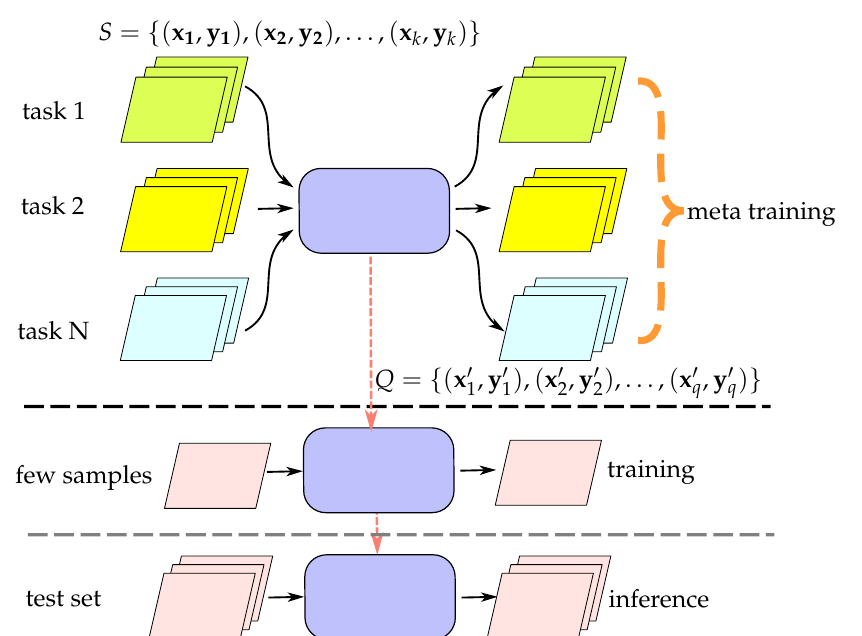
Figure 2. The proposed meta-learning architecture. The orange dashed line represents the flow of weights in the model. During the meta-learning stage, N tasks are used to train the model, each with the goal of identifying different forgery techniques. The weights trained during the meta-learning stage are fine-tuned during the fine-tuning stage. Finally, the fine-tuned weights are used for